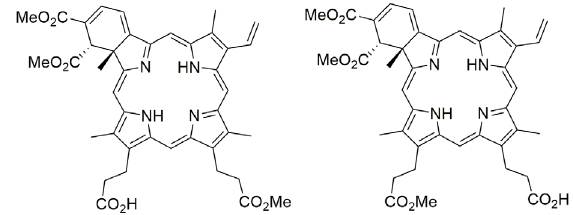
Figure 8 - Structures of Visudyne isomeric mixture.